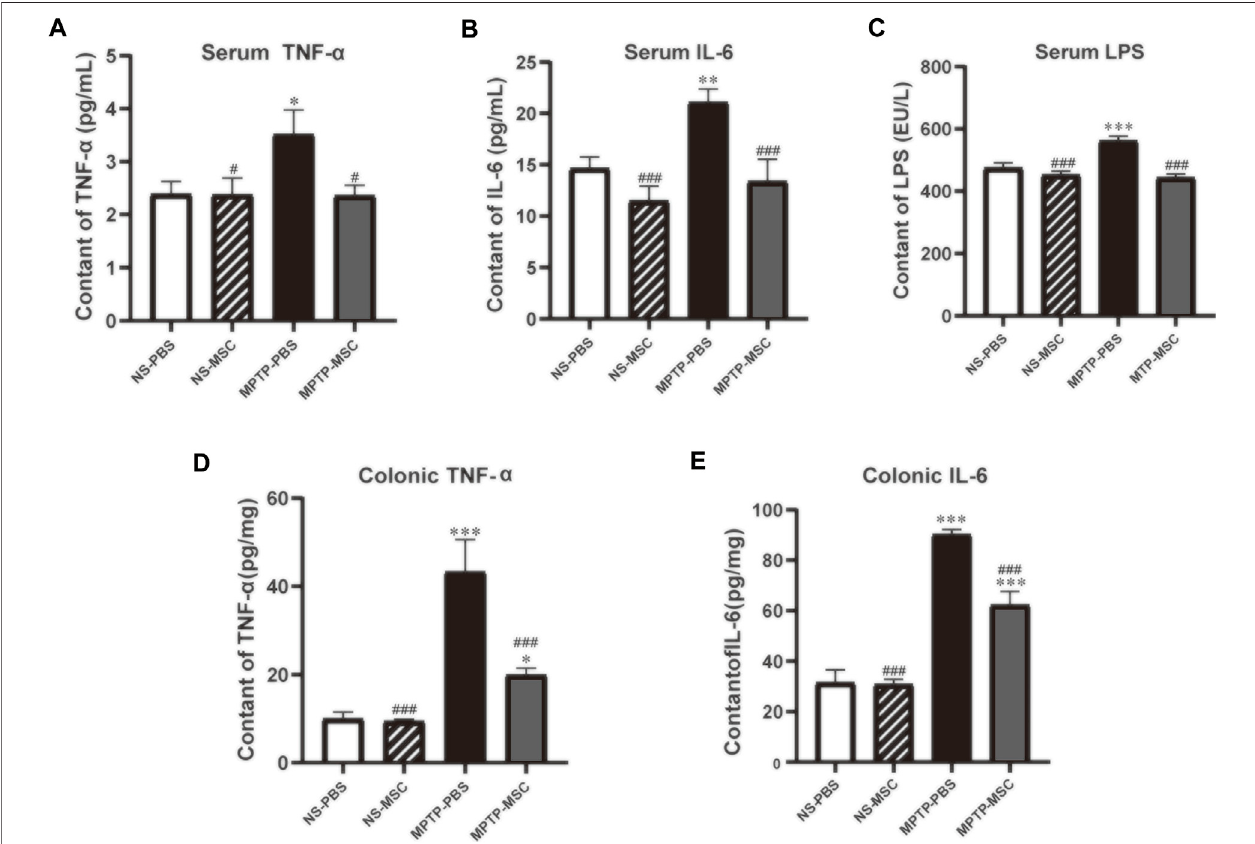
FIGURE 6 | UC-MSCs alleviated serum and colonic in fl ammatory cytokines in PD mice. Serum levels (pg/ml) of TNF- α (A) , IL-6 (B) , and LPS (C) in mice; colonic levels (pg/mg) of TNF- α (D) and IL-6 (E) in mice. Data of (A – E) ( n (cid:1) 5 – 6 per group) are expressed as mean ± SE. * p < 0.05, ** p < 0.01, *** p < 0.001 compared with NS- PBS group, # p < 0.05, ### p < 0.001 compared with MPTP-PBS group by one-way